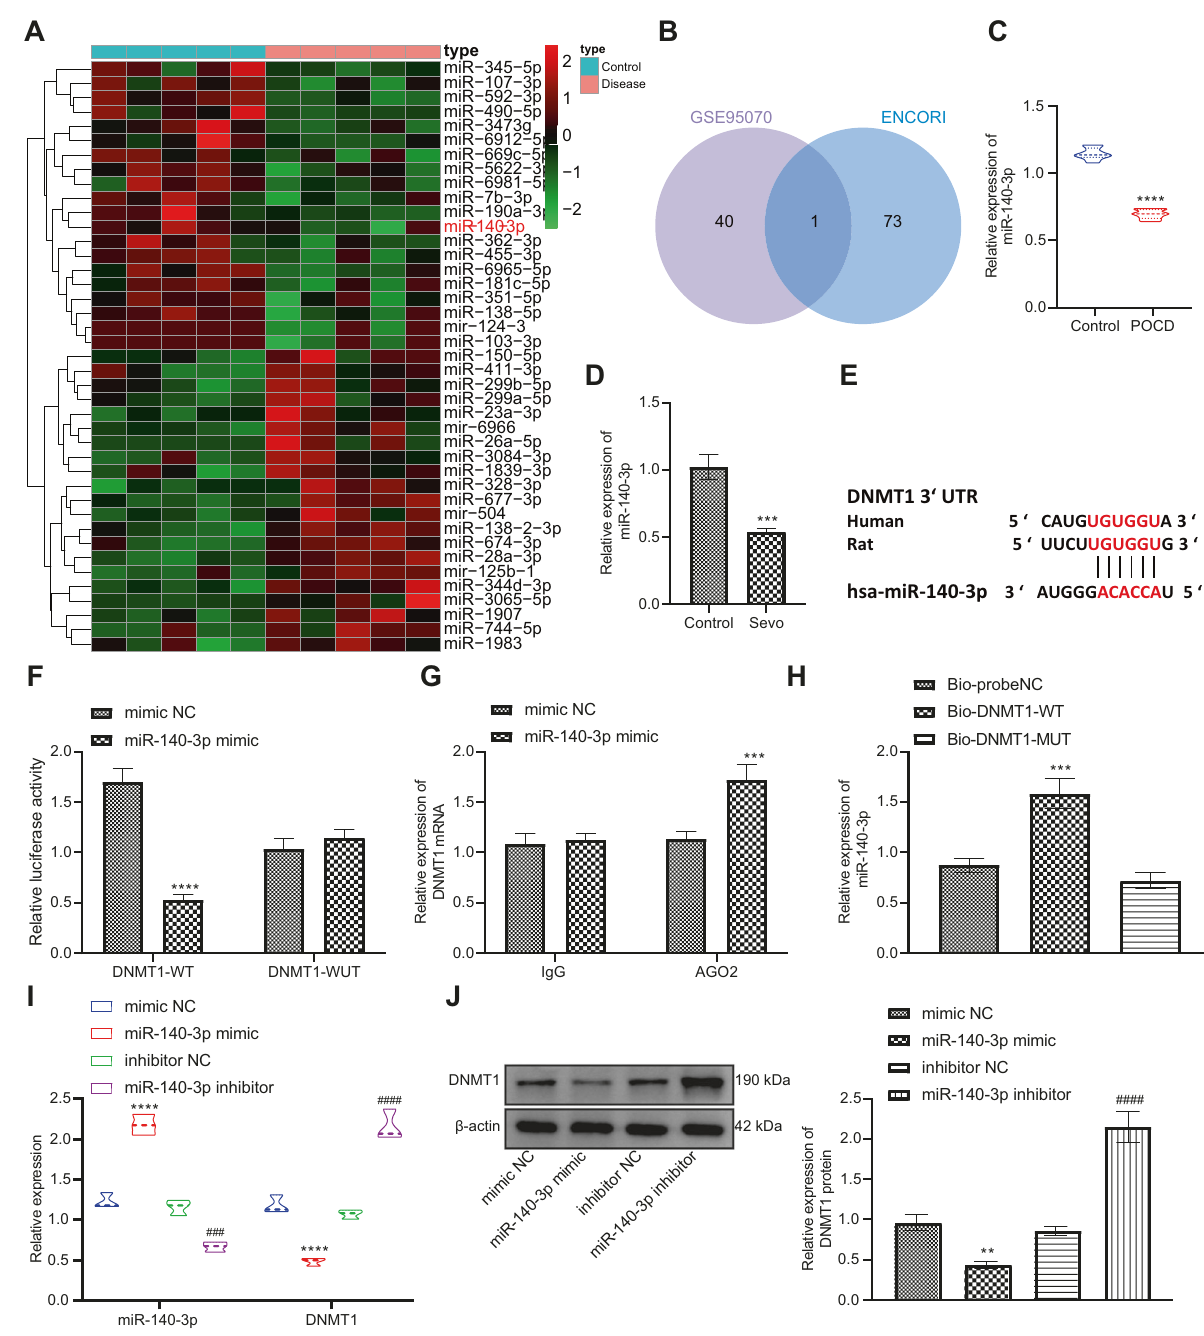
Fig. 5 DNMT1 is negatively targeted by miR-140-3p in rat hippocampal neurons. A The heat map showing low expression of miR-140-3p in GSE95070 in POCD samples. B Venn map of intersection of the predicted miRNAs targeting DNMT1 in ENCORI8 database with the differentially expressed miRNAs in GSE95070. C The detection of expression of miR-140-3p in the hippocampal tissues of rats after POCD modeling by RT-qPCR (There were ten rats in each group. * p < 0.05, ** p < 0.01, and *** p < 0.001 vs. the rats without POCD). D The detection of expression of miR-140-3p in hippocampal neurons after Sevo treatment by RT-qPCR (The experiment was repeated three times; * p < 0.05, ** p < 0.01, and *** p < 0.001 vs. the control neurons). E The prediction of binding sites of miR-140-3p and DNMT1 by ENCORI database. F Dual- luciferase reporter assay for assessing the targeted binding of miR-140-3p and DNMT1 (The experiment was repeated three times; * p < 0.05, ** p < 0.01, and *** p < 0.001 vs. mimic NC treatment). G The detection of interaction between miR-140-3p and DNMT1 by RIP assay (The experiment was repeated three times; * p < 0.05, ** p < 0.01, and *** p < 0.001 vs. mimic NC treatment). H The analysis of interaction between miR-140-3p and DNMT1 by RNA pull-down (The experiment was repeated three times; * p < 0.05, ** p < 0.01, and *** p < 0.001 vs. Bio-DNMT1- MUT and Bio-probeNC). I The detection of expression of miR-140-3p and DNMT1 in hippocampal neurons after miR-140-3p mimic or inhibitor treatment by RT-qPCR. J Western blot analysis to detect the protein expression of DNMT1 in hippocampal neurons after miR-140-3p mimic or inhibitor treatment. In I , J , the experiment was repeated three times; * p < 0.05, ** p < 0.01, and *** p < 0.001 vs. the neurons treated with mimic NC, # p < 0.05, ## p < 0.05, and ### p < 0.05 vs. the neurons treated with inhibitor